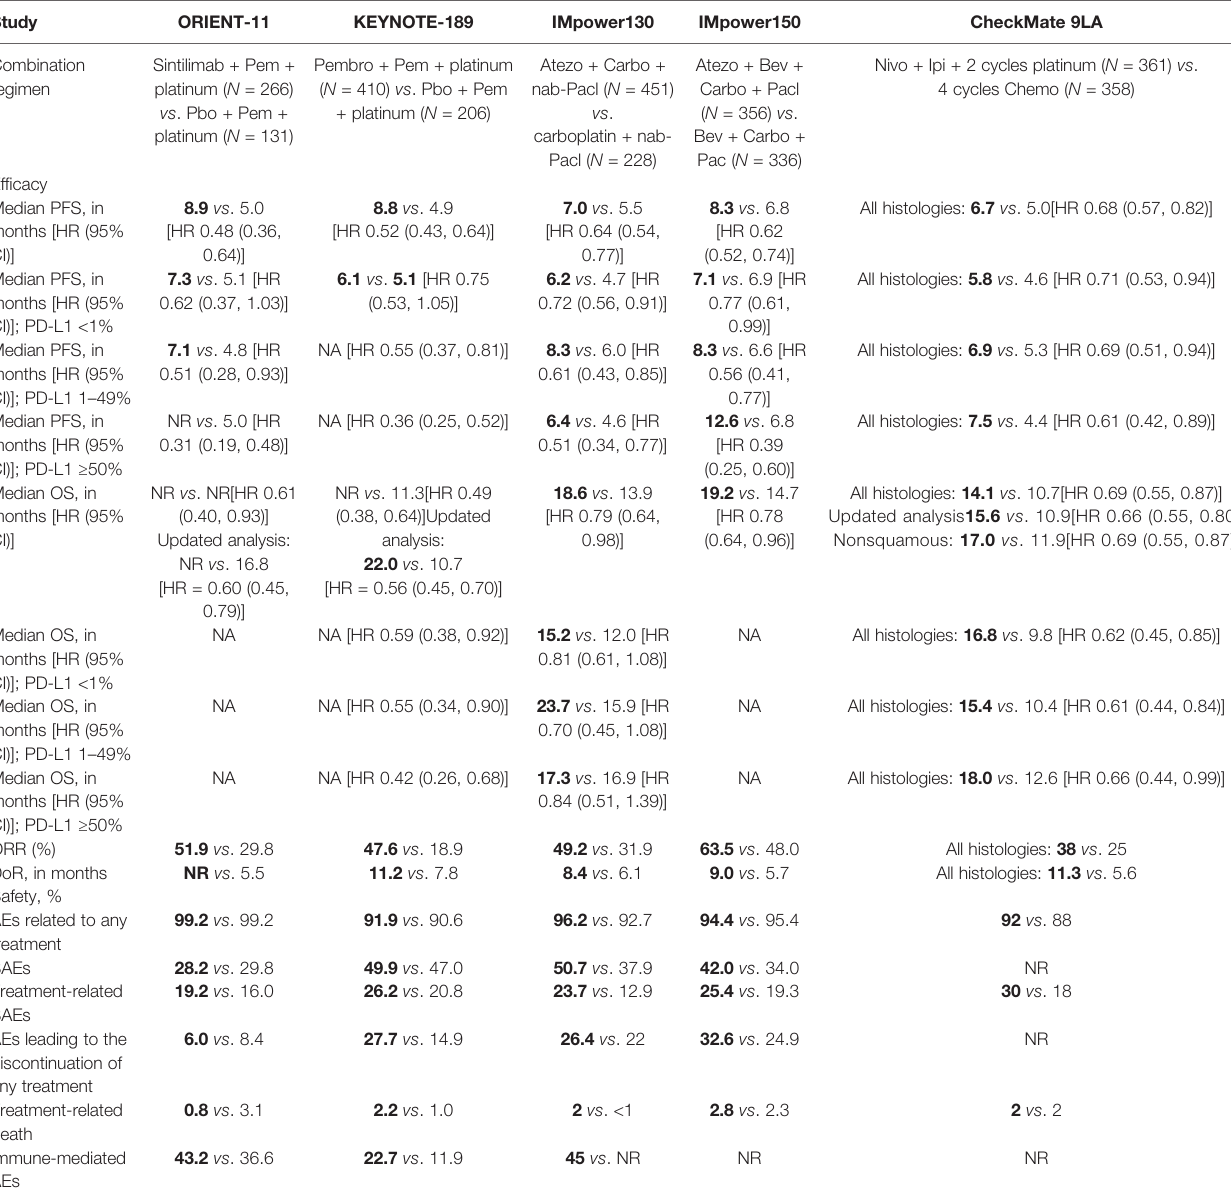
TABLE 2 | Ef fi cacy outcomes and safety of ORIENT-11, KEYNOTE-189, IMpower130, IMpower150, and CheckMate 9LA.